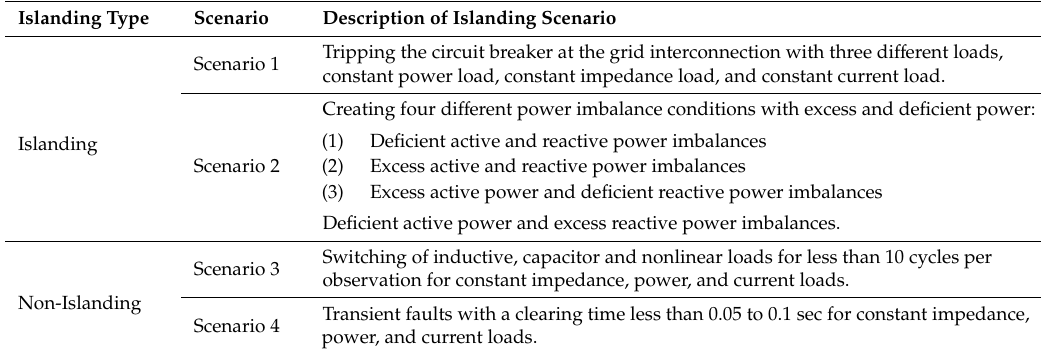
Table 1. Description of di ff erent islanding scenarios considered for developing the classifier.